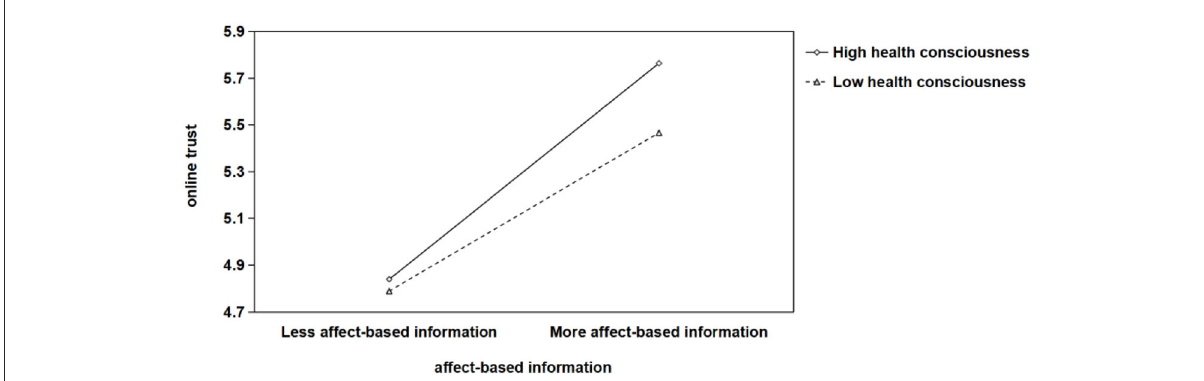
FIGURE4 Interaction chart for different levels ( ± 1 standard deviation) of health consciousness in the mediating model of “institution-based information → online trust → patients’ willingness to conduct online health consultation”.